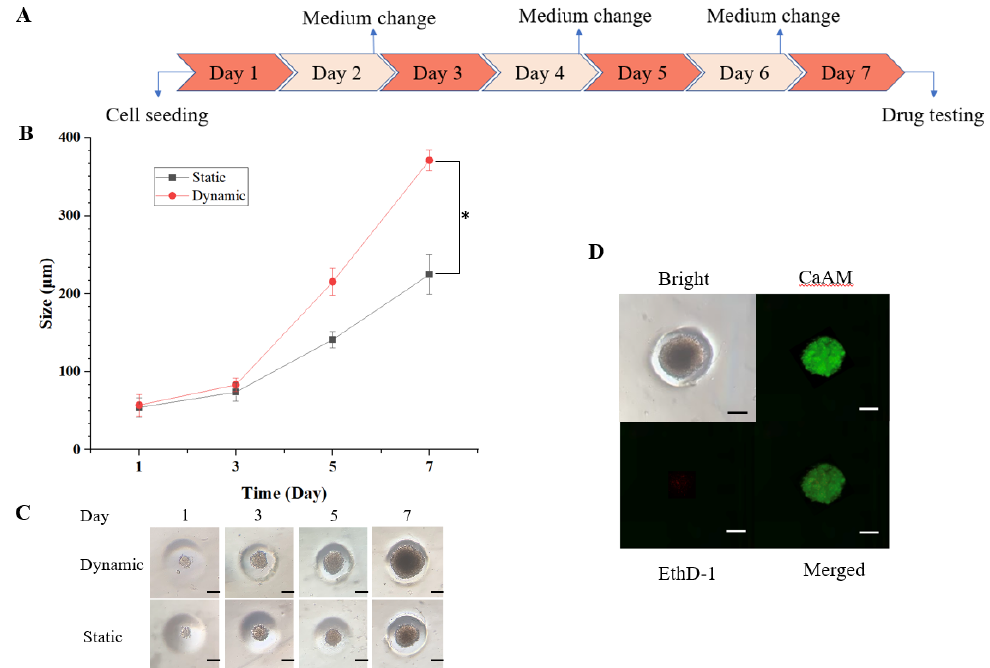
Figure 4. The development of cancer spheroids in the microfluidic device over 7 days. ( A ) The spheroid culture process for 7 days is summarized in this time chart. ( B ) The spheroids cultured in both static and dynamic media showed better growth under dynamic conditions, (* p < 0.05). ( C ) The spheroids were cultured and grown for 7 days. Scale bar = 150 µm. ( D ) The live/dead assay for the cell spheres after 7 days showed positive viability in the dynamic environment: bright image, live cells with green fluorescence (CaAM), dead cells with red fluorescence (EthD-1), and merged images.